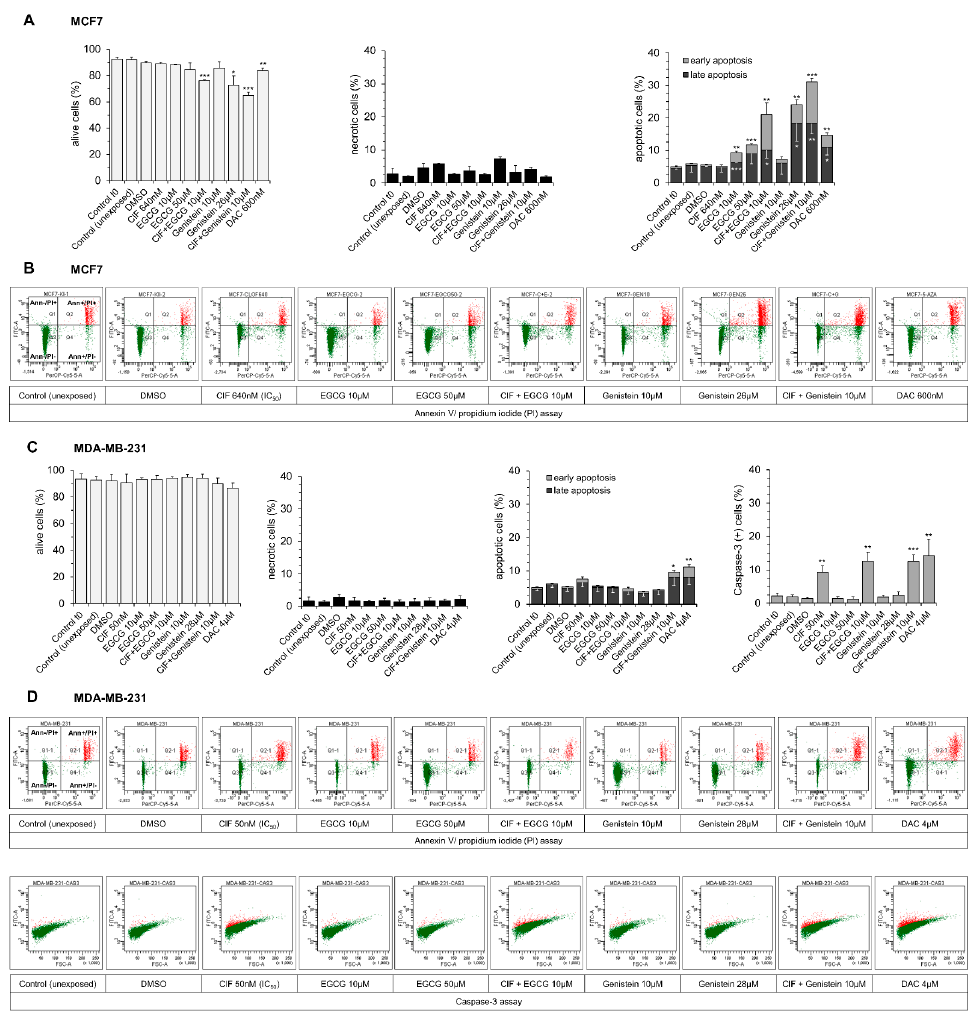
Figure 2. Effects of ClF (IC 50 ) and EGCG (10 µ M) or genistein (10 µ M) alone and in combination on the number of alive, apoptotic and necrotic cells as well as on caspase 3 activity (only in MDA-MB-231 cells) in MCF7 ( A , B ) and MDA-MB-231 ( C , D ) cell lines. The original FACS cytograms of annexin V/propidium iodide and caspase 3 (only in MDA-MB-231 cells) assays for MCF7 ( B ) and MDA-MB-231 ( D ) cells are shown. Values are means ± S.D. of three independent experiments. Exposure versus vehicle control: *** p < 0.001, ** p < 0.01, * p < 0.05. Ct0, control cells used for experiments (time 0 h); Control (unexposed), negative control, cells incubated with medium; DAC, positive control; DMSO, vehicle control; Q1, necrotic cells (Ann − /PI+); Q2, late apoptotic cells (Ann+/PI+); Q3, viable cells (Ann − /PI − ); Q4, early apoptotic cells (Ann+/PI −